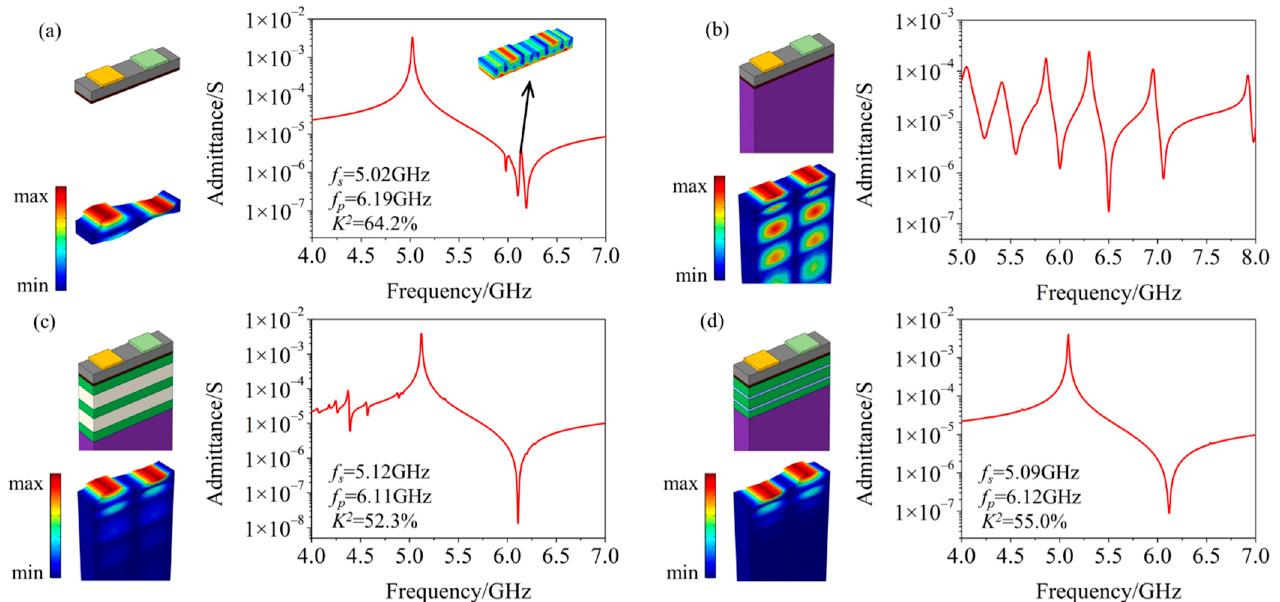
Figure 4. Structures, calculated admittance, and BAW field distribution in the resonance of four different YBARs. ( a ) Sus- pended Al-LiNbO 3 -Pt, ( b ) Al-LiNbO 3 -Pt mounted on Al 2 O 3 substrate, ( c ) an alternately arranged SiO 2 -Al 2 O 3 multilayer (served as a BAW Bragg Reflector) added between the Al-LiNbO 3 -Pt layer and the Al 2 O 3 substrate, ( d ) an alternately arranged SiO 2 -Pt multilayer (also served as a BAW Bragg Reflector) added between the Al-LiNbO 3 -Pt layer and the Al 2 O 3 substrate.